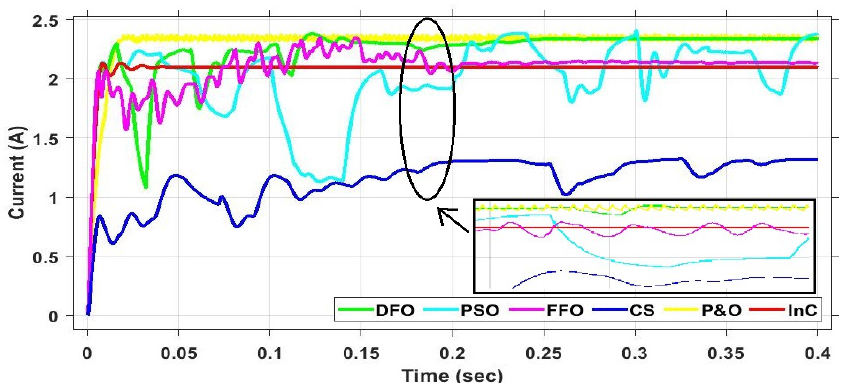
Figure 32. PS3 current comparison between all algorithms for MLPE Distributed PV system.